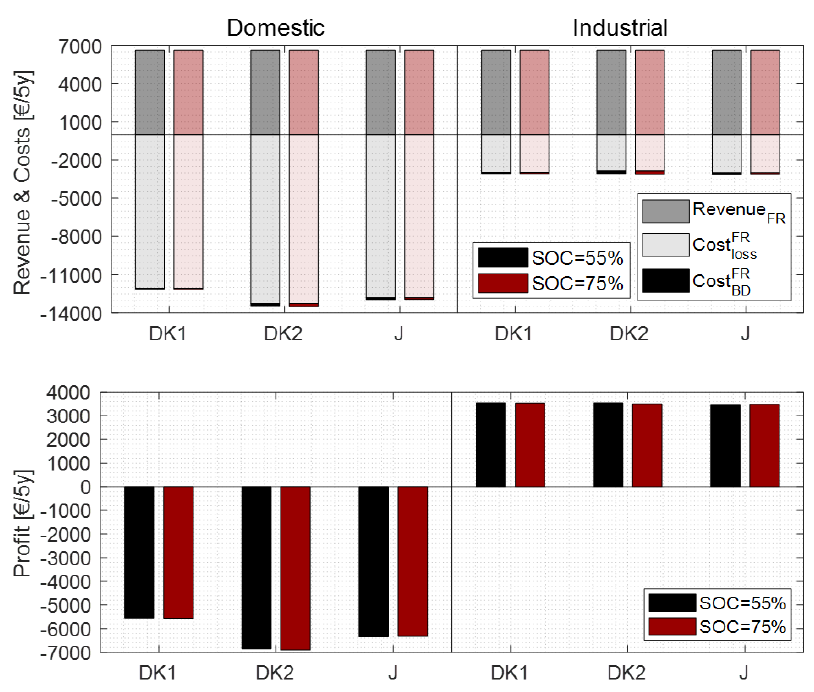
Figure 11. Comparison of domestic and industrial cases, in black for SOC equal to 55% and in red for SOC equal to 75%, in DK1, DK2 and JP; revenues and costs in the first subplot, profits in the second